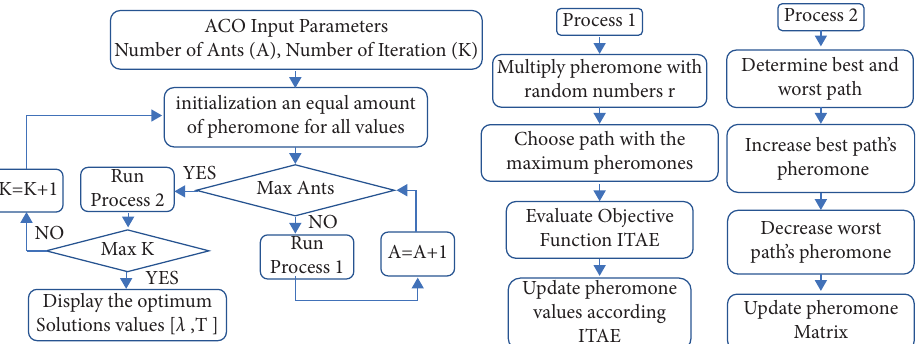
Figure 5: DTSC tuning of ant colony optimization fowchart.